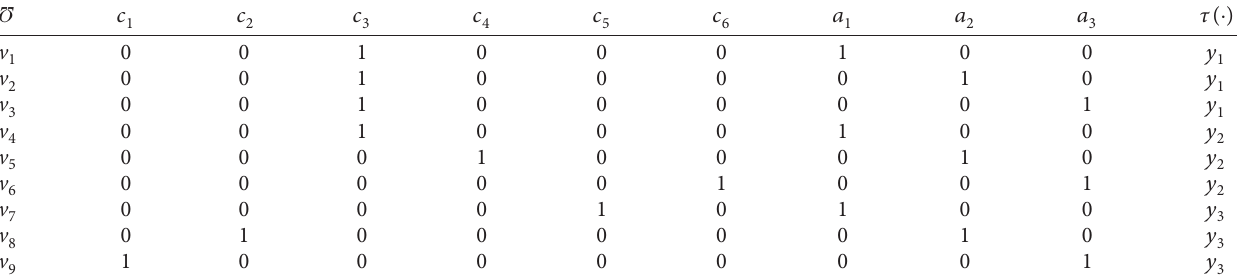
Table 4: Tabular representation of the TSS T � ( 􏽢 F,B, τ , Y )